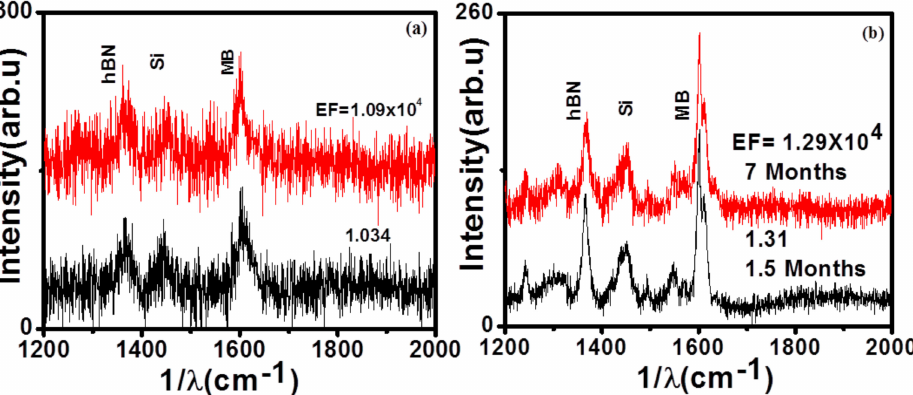
Figure 6. ( a ) Raman enhancement after regenerating hBN films: ( a ) 1 uM MB on 7 nm thick hBN film and ( b ) 1 µ M MB by 6 nm film at different time durations after their